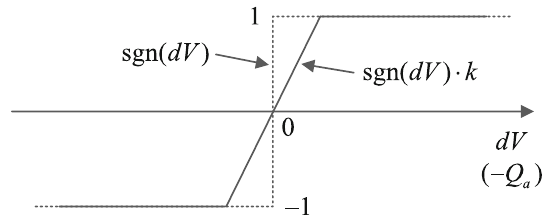
Fig. 2 Illustration of pressure drop